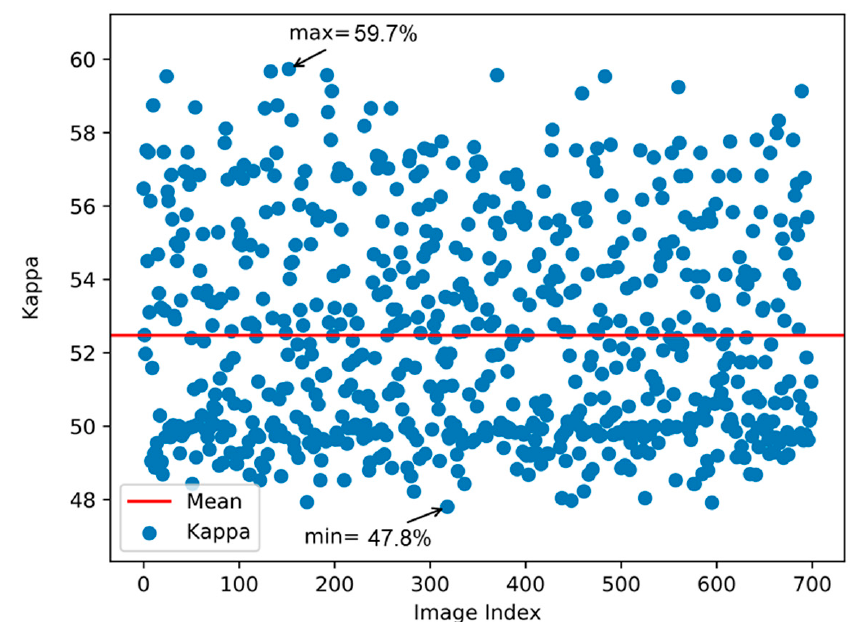
Figure 4. Kappa values of the classification results derived when a single-angle image was used as the input data. The red line represents the average of every single-angle kappa value of the classi- fication results.